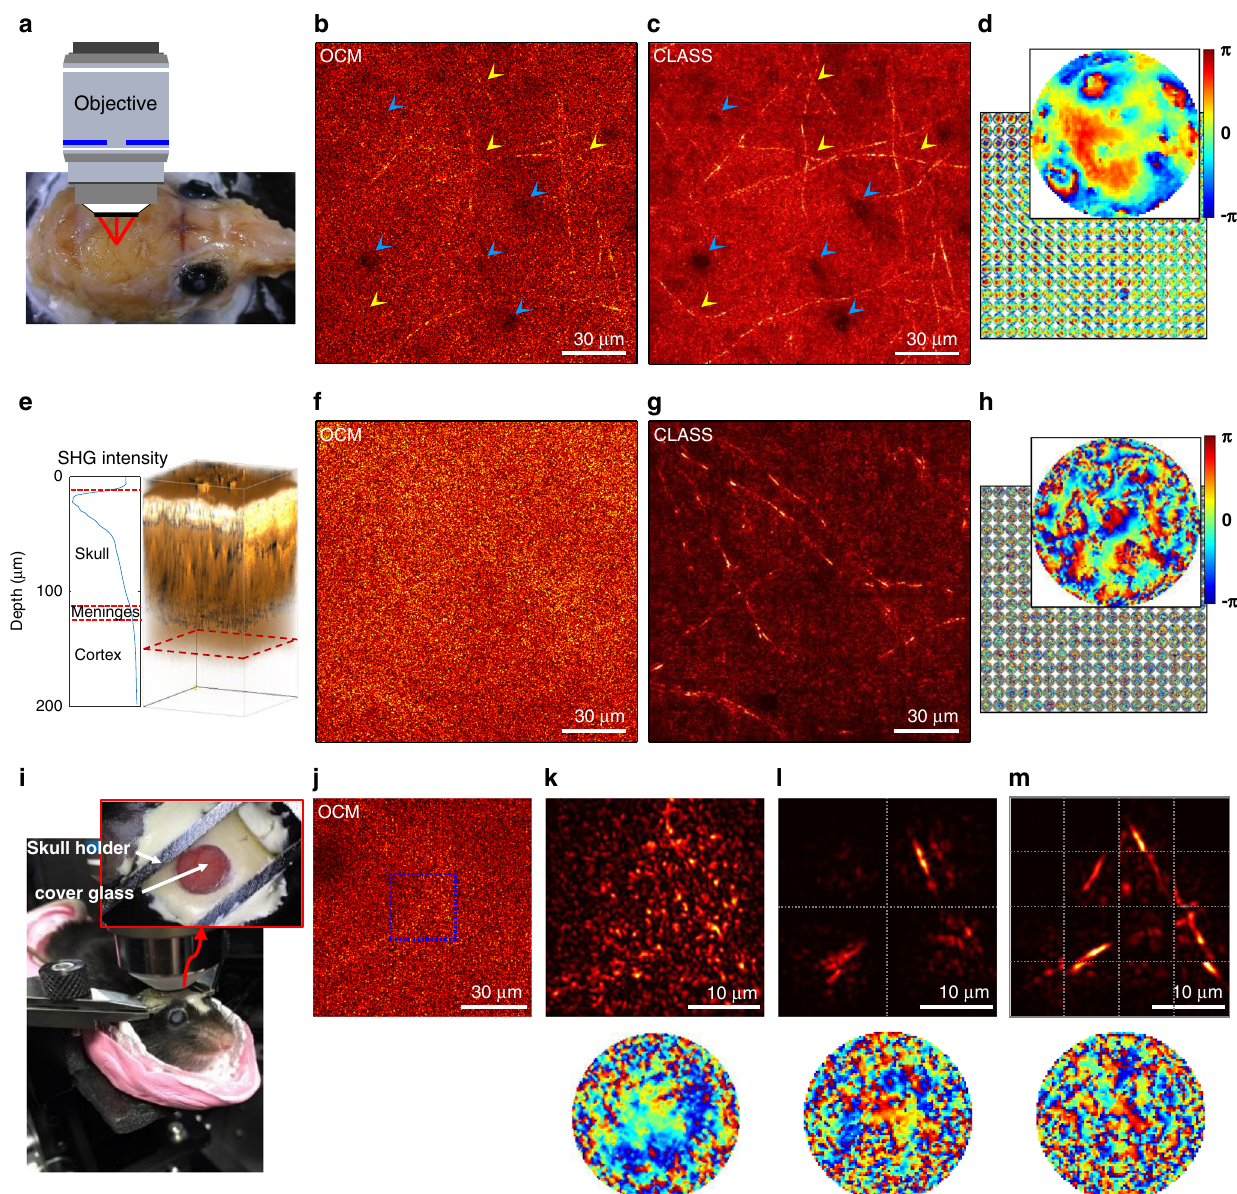
Fig. 3 Imaging of myelinated axons through a mouse skull. a Ex vivo specimen of a fi xed mouse head. b – d Ex vivo imaging of mouse brain through the thinned skull of a 7-week-old mouse. The thickness of the thinned skull was approximately 40 µ m. b Conventional OCM amplitude image of myelinated fi bers in the fi rst cortex layer at a depth of 70 µ m from the upper side of the thinned skull. c Aberration-corrected CLASS amplitude image. The CLASS algorithm was individually applied to 18 × 18 subregions to correct local aberrations, and the corrected images were stitched together. The size of each subregion is ~11 × 11 µ m 2 , including overlap with adjacent areas. Microvessels (blue arrowheads) and myelinated axons (yellow arrowheads) are more clearly visible in the CLASS image. d Retrieved aberration maps for the detection pathway. The magni fi ed map shows a representative aberration map. The number of correction modes N c for each aberration map in d , set by the FOD, was about 3500. Color bar, phase in radians. e – h Ex vivo imaging through intact skull of an 8-week-old mouse. The thickness of the skull was about 100 µ m. e 3D reconstruction of SHG imaging of an intact mouse skull. The dashed red box indicates the depth at which CLASS imaging was performed. It was located 150 µ m below the upper surface of the skull. f OCM amplitude image of myelinated fi bers. Myelinated fi bers are almost invisible. g , h CLASS amplitude image and corresponding aberration maps, respectively. The image was analyzed as in c and d . N c in h was about 10,000. i Experimental setup for in vivo imaging through intact mouse skull. The thickness of the skull was 125 − 150 µ m. j OCM intensity image of myelinated fi bers at a 200- µ m depth from the upper surface of the skull. k CLASS intensity image (upper) and the corresponding aberration map (lower) for a 30 × 30 µ m 2 area marked by the blue dotted box in j . l , m CLASS intensity images with their representative aberration maps for one of the 2 × 2 and 4 × 4 subregions, respectively. N c used in aberration maps in k – m was about 3500. The skull thicknesses and imaging depths reported here are the raw axial movement of the sample